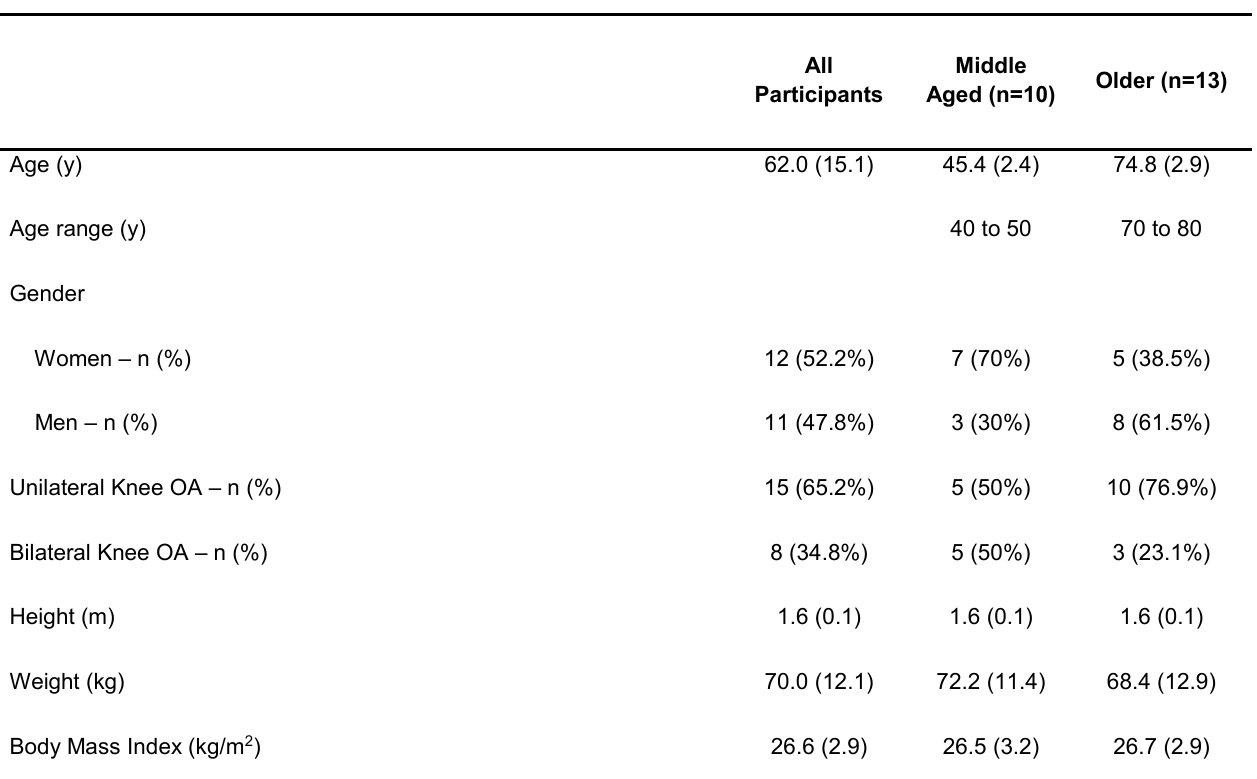
Characteristics of